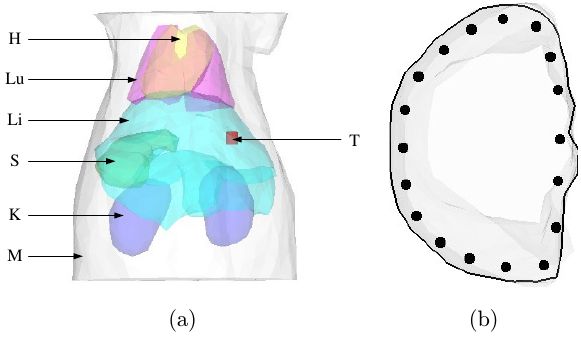
Fig. 2. (a) 3D digital mouse model consisting of heart (H), lungs (Lu), muscle (M), liver (Li), kidneys (K), stomach (S), muscle (M) and target (T). (b) A total of 18 excitation sources placed around the surface at z ¼ 16 : 4 mm plane.